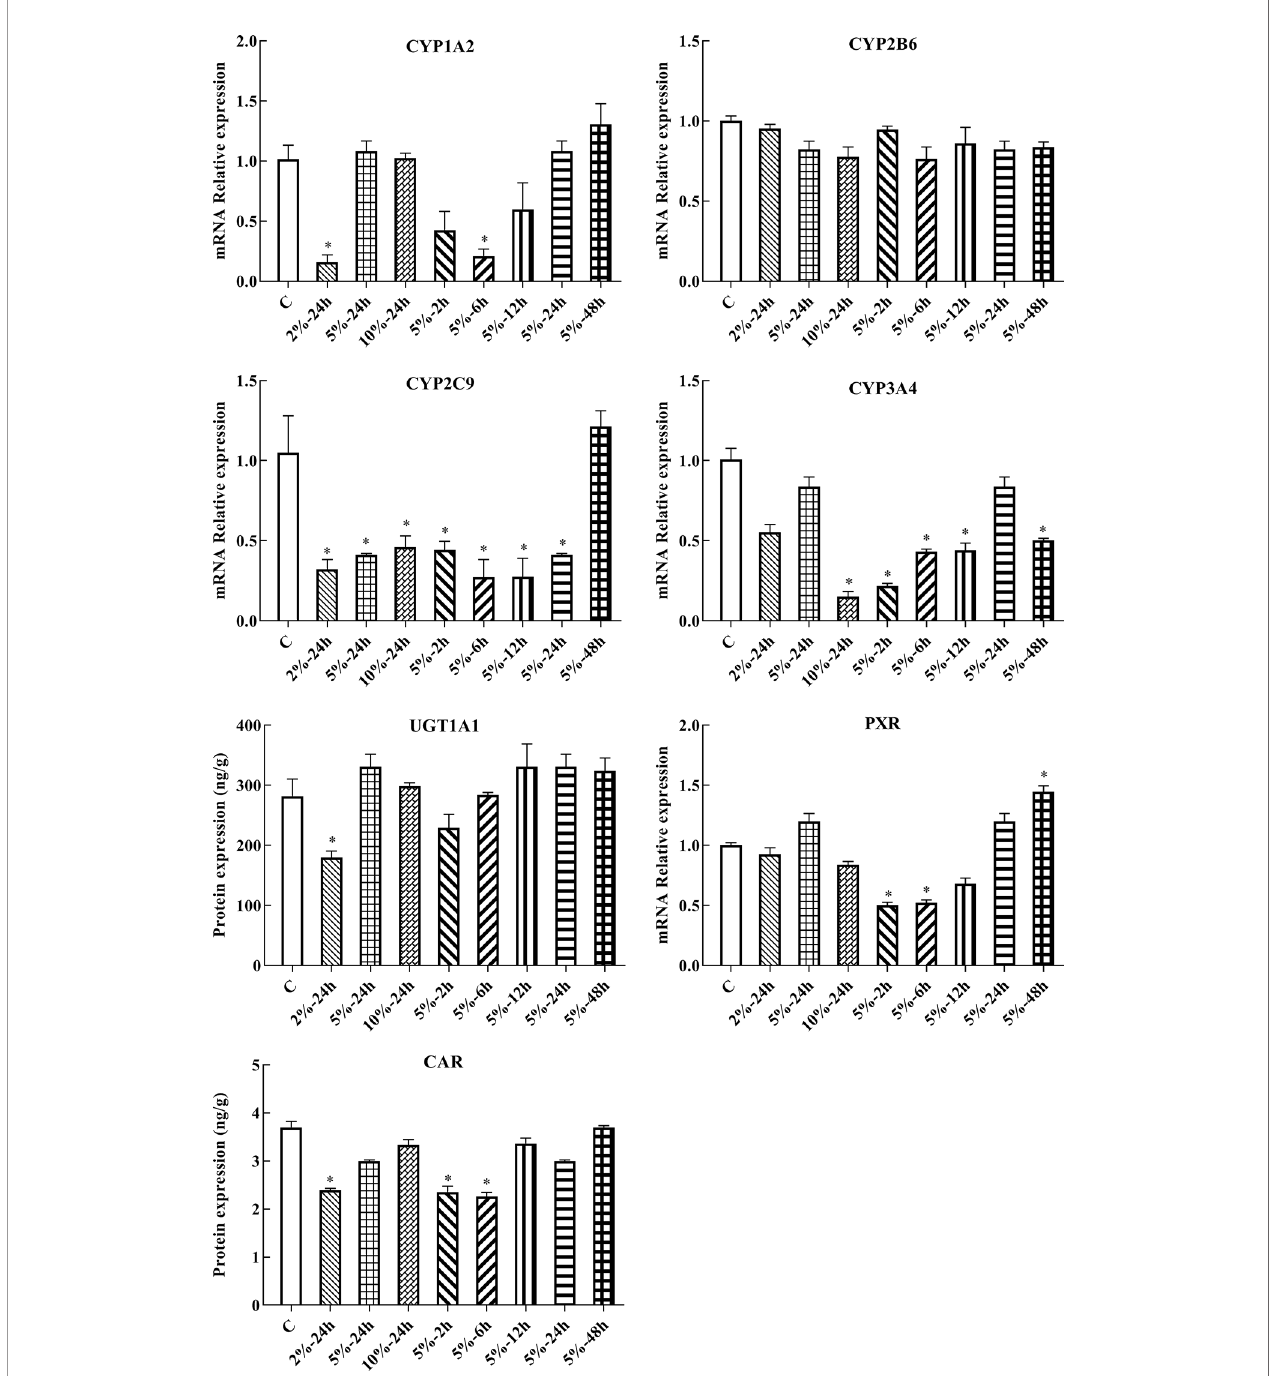
FIGURE 5 | mRNA expression of Cyp1A2, Cyp2B6, Cyp2C9, Cyp3A4, Ugt1A1, Pxr, and Car in HepG2 cells. C: control group, HepG2 cells were cultured in a normoxic humidi fi ed incubator. HepG2 cells were exposure to 2% O 2 for 24 h (2%-24 h), 5% O 2 for 24 h (5%-24 h), 10% O 2 for 24 h (10%-24 h), 5% O 2 for 2 h (5%-2 h), 5% O 2 for 6 h (5%-6 h), 5% O 2 for 12 h (5%-12 h), 5% O 2 for 24 h (5%-24 h), and 5% O 2 for 48 h (5%-48 h). The data were analyzed using a one-way analysis of variance (ANOVA), and the differences between the means of two groups were compared using LSD tests. * indicates the signi fi cance of experimental groups, compared with that of the control. Values are expressed as Mean ± SEM (n = 3). Levels are considered signi fi cant at * p <